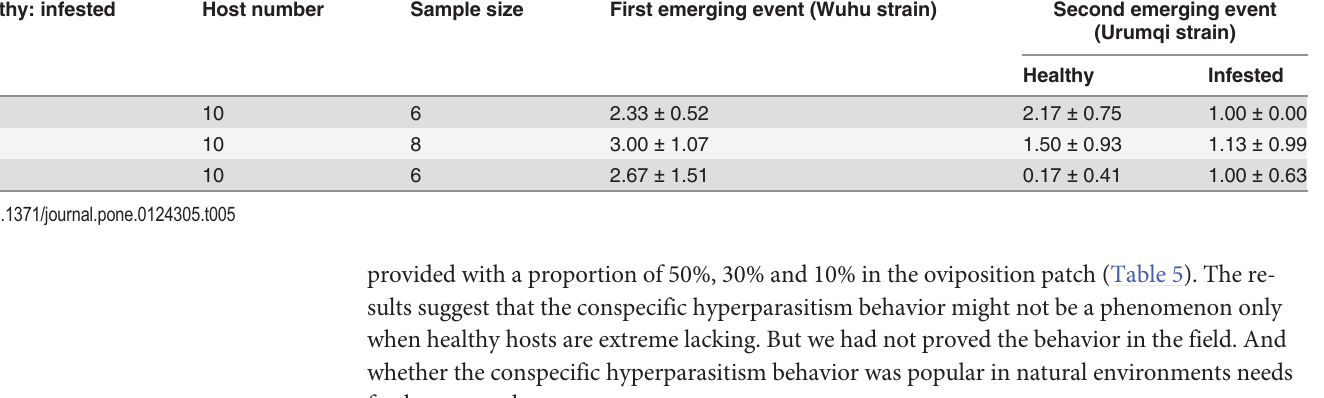
Table 5. Offspring number emerging from healthy and infested hosts when exposed to P . vindemmiae females together. Healthy: infested Host number